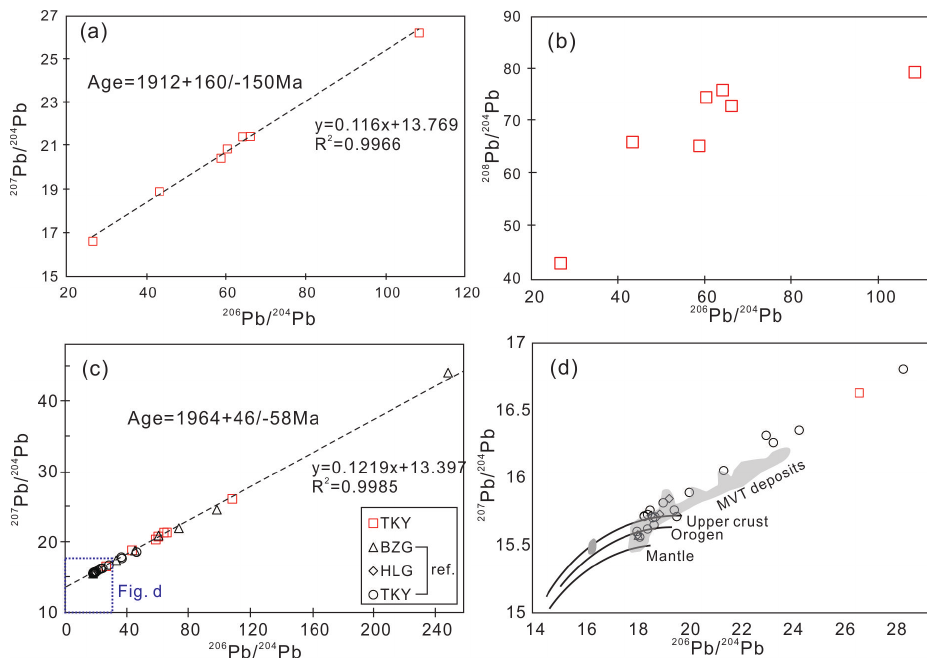
Figure 6. ( a , b ) Plots of 206 Pb/ 204 Pb versus 207 207Pb/ 204 Pb and 208 Pb/ 204 Pb versus 206 Pb/ 204 Pb of sulfides of the Tongkuangyu Cu deposits, North China Craton; ( c ) A plot of 206 Pb/ 204 Pb versus 207 Pb/ 204 Pb with previous data of Tongkuangyu, Bizigou and Henglingguan; ( d ) A comparison between Zhongtiao mountain and other Pb reservoirs (adapted from